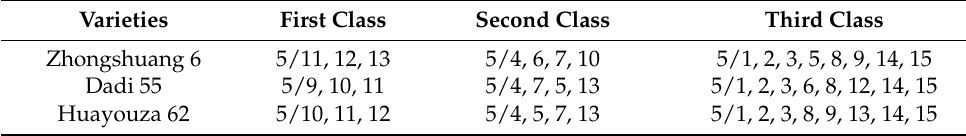
Table 2. Classification of rapeseed yield data. Varieties First